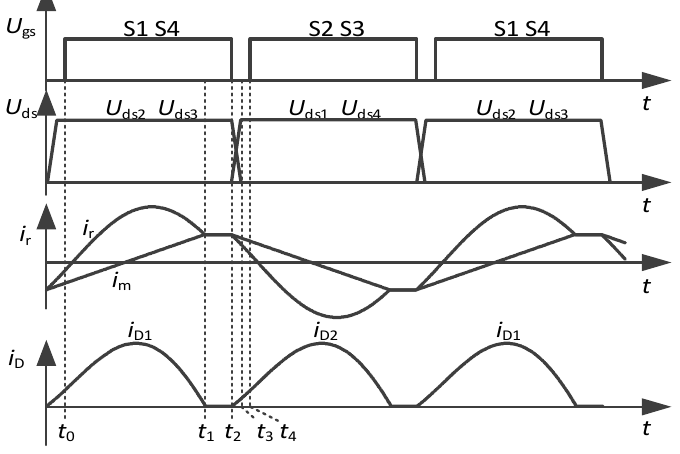
Figure 2. Operation waveforms of LLC resonant converter.